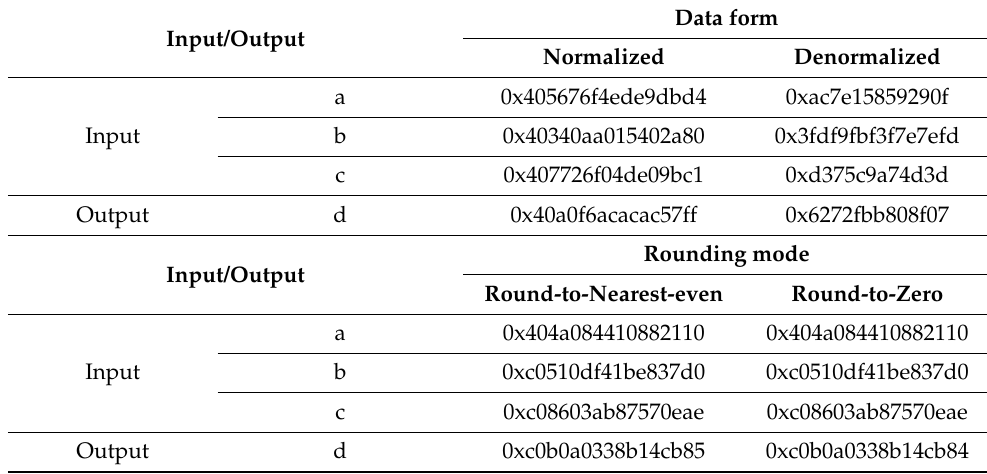
Table 1. Sample 1 results of DCIM-FF